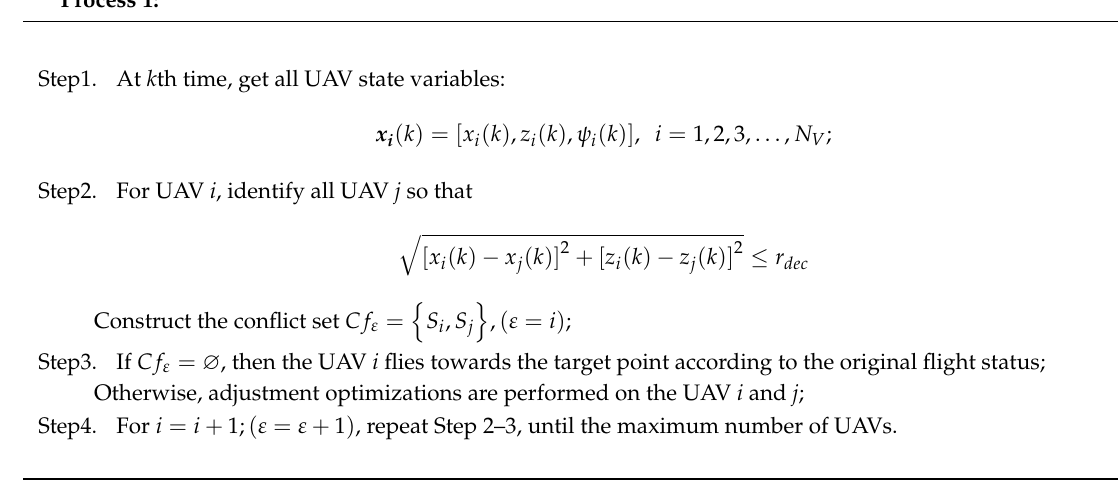
Figure 5. State Machine of UAV flight.